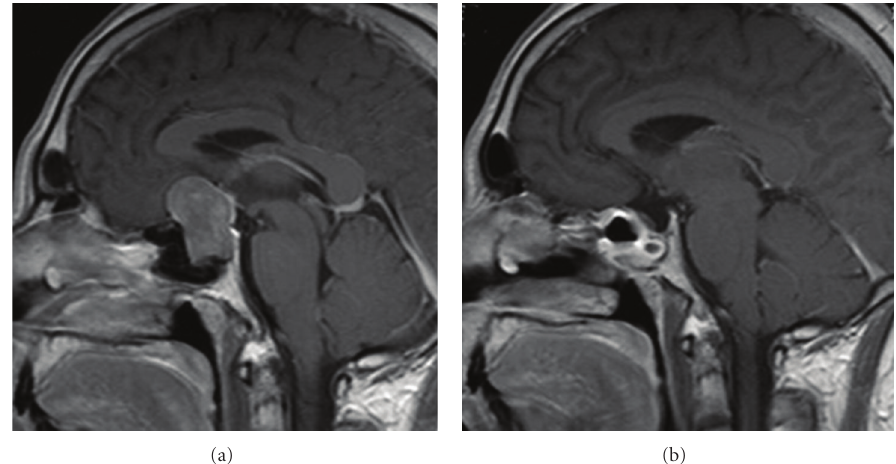
Figure 6: Enhanced MRI sagittal view. In this case, the tumor presented a small portion growing toward the anterior cranial floor (a). An extended TS approach was used and the tumor could be successfully taken out